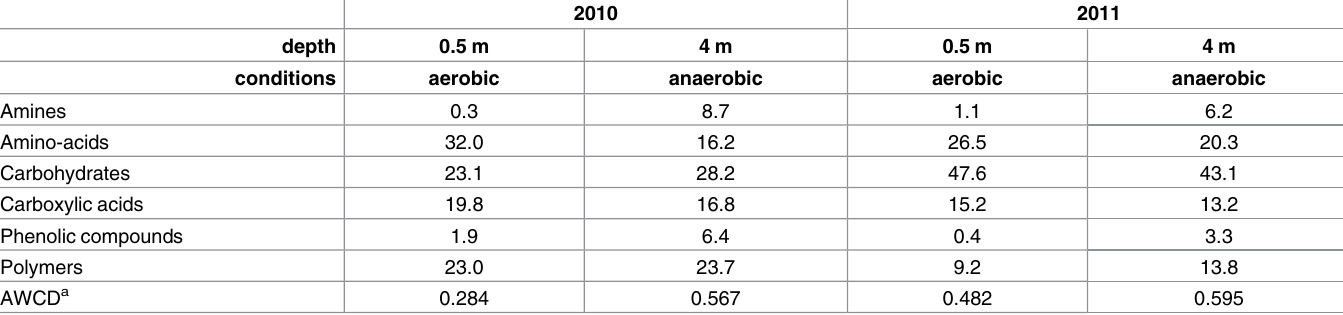
Table 6. Percentages of substrate (regrouped by chemical classes)utilization for each sampling condition during the two experiments in 2010 and